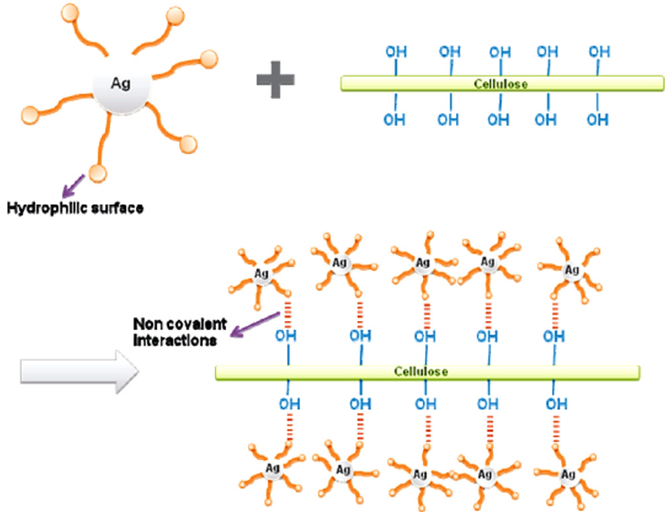
Figure 2. The synthesis mechanism for the formation of Ag nanoparticles on the surface of the CNCs. Reprinted with permission from [ 16 ] . Copyright 2010 American Chemical Society.